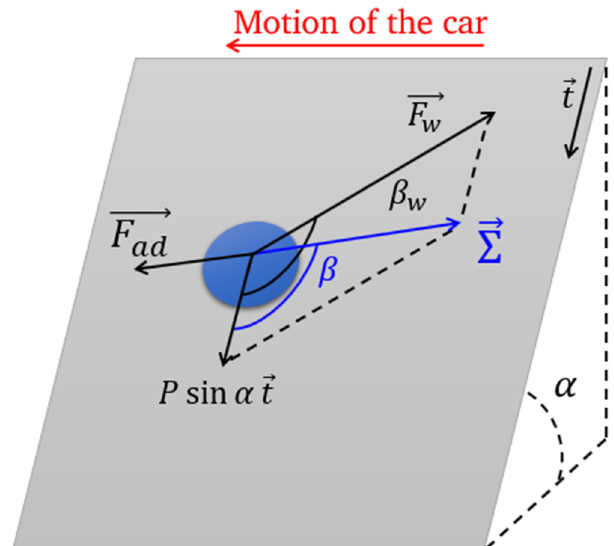
Fig. 2. Schematic view of the three forces applying on a drop, holding on a tilted plane of inclination a and under a wind of given direction b w on the plane. ~ t is an unit vector tangential to the ~ S plane. The sum of the two external forces (weight P sin a ~ t and ~ F w ) is represented in blue. The angle between drag force is de fi ned as b .